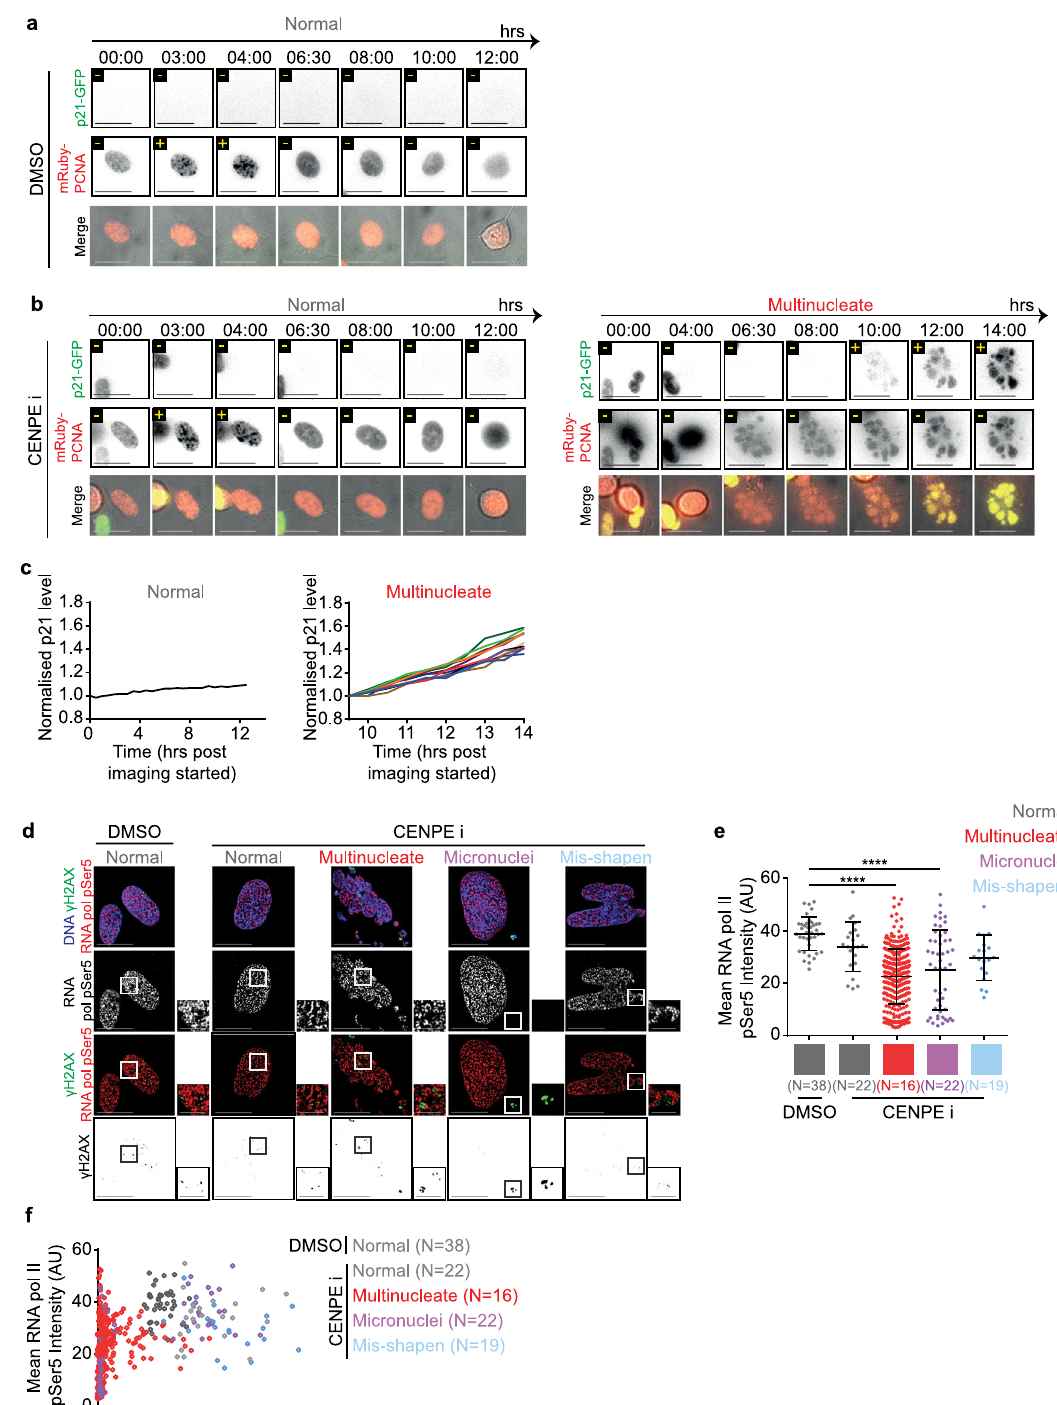
(Supplementary Fig. 6b, g), revealing a nuclear compartment size cut-off for transcription in multi-nucleated cells. These data show exclusion of transcription at MADD sites and a size-dependent reduction in transcription in multinucleated and micronucleated compartments. In summary, the studies of RNA-pol phosphor- ylation provide three key insights: (i) multinucleated cells are not dead and are transcriptionally active; (ii) multinucleation induces heterogeneity within nuclear compartments with